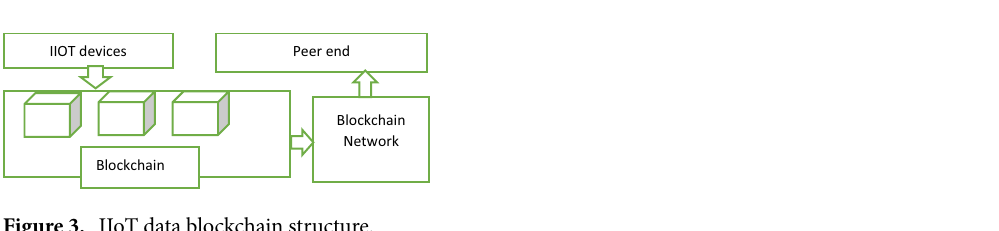
Figure 3. IIoT data blockchain